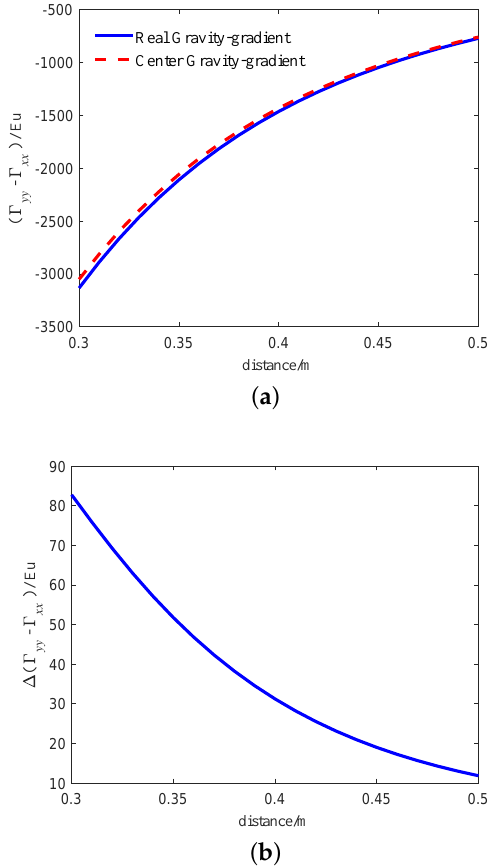
Figure 6. Gravity-gradient of the two models based on the cuboid. ( a ) The relationship between the calculated results of the two models and the distance. ( b ) The relationship between the calculated results error of the two models and the